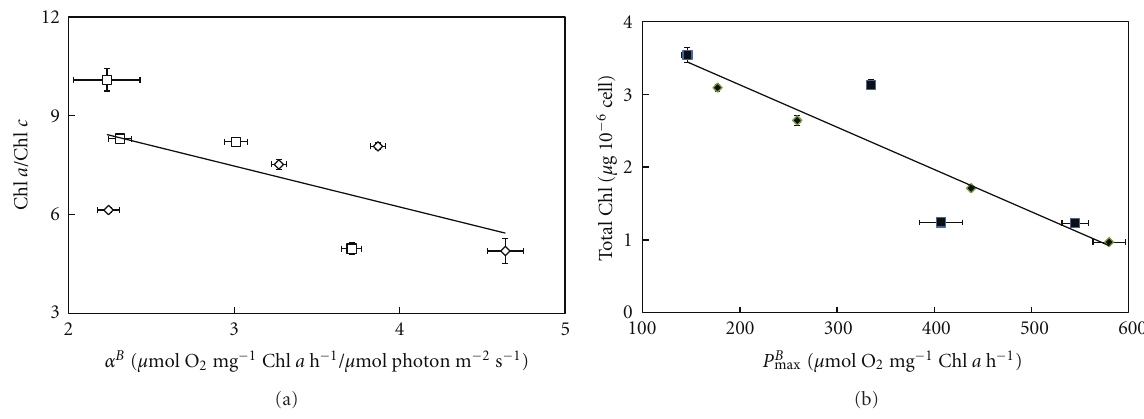
Figure 2: (a) Relationship between α B calculated from gross photosynthesis versus light intensity curves ( P/E in Figure 1) and Chl a /Chl c ratio (Table 1) in Amphora co ff eaeformis, Amphora acutiuscula, Entomoneis paludosa, and Nitzschia palea grown in ASW in the absence ( (cid:2) ) or the presence ( ♦ ) of Zn supplementation. (b) Relationship between the total Chl content (Table 1) and the maximum gross photosynthesis ) (Figure 1) in Amphora co ff eaeformis, Amphora acutiuscula, Entomoneis paludosa, and Nitzschia palea grown in ASW in the absence ( P B max ( (cid:4) ) or the presence ( (cid:5) ) of Zn